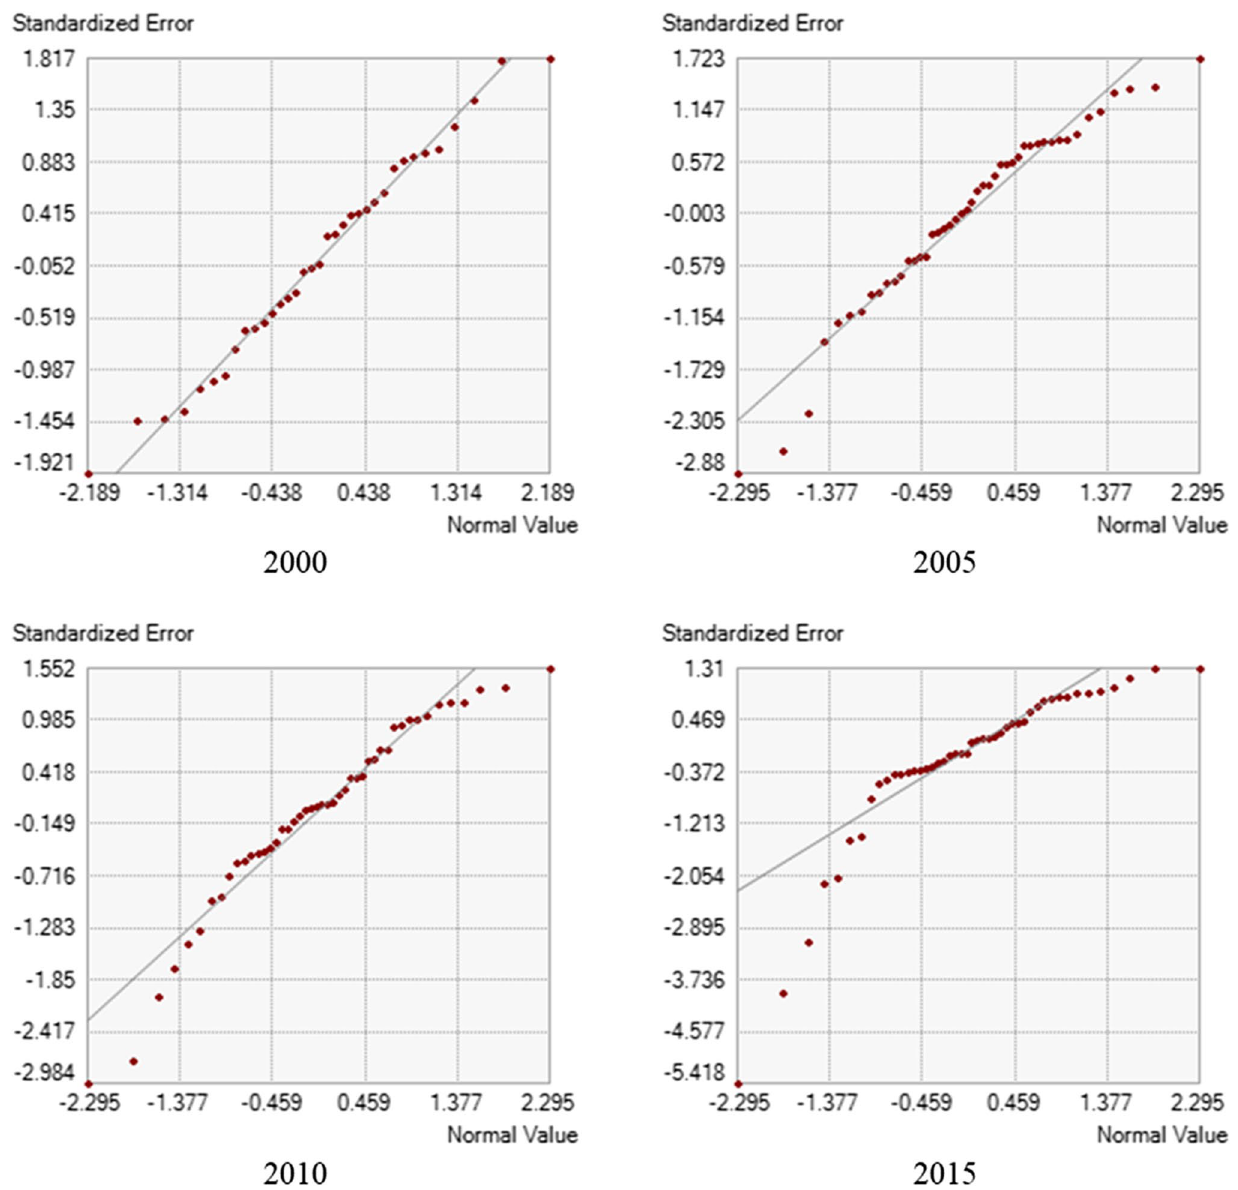
Fig. 5 Quantile–Quantile (QQ) plot for the residual of the prediction map of 2000, 2005, 2010, and